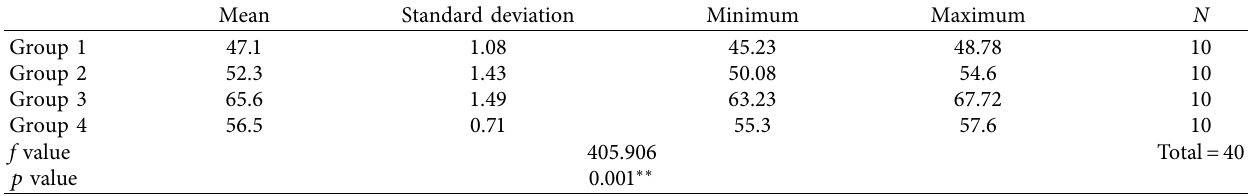
Table 1: Overall comparison of shear bond strength of Ni-Cr alloy samples using ANOVA.